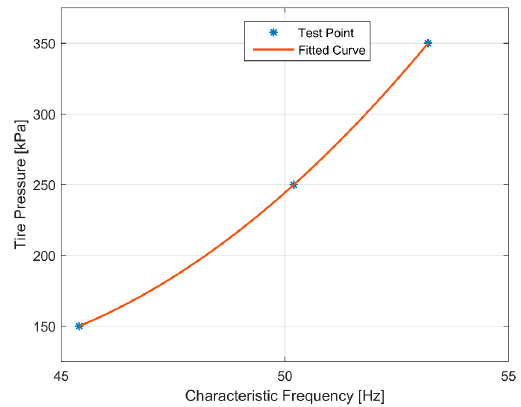
Figure 11. Relationship between characteristic frequency and tire pressure.